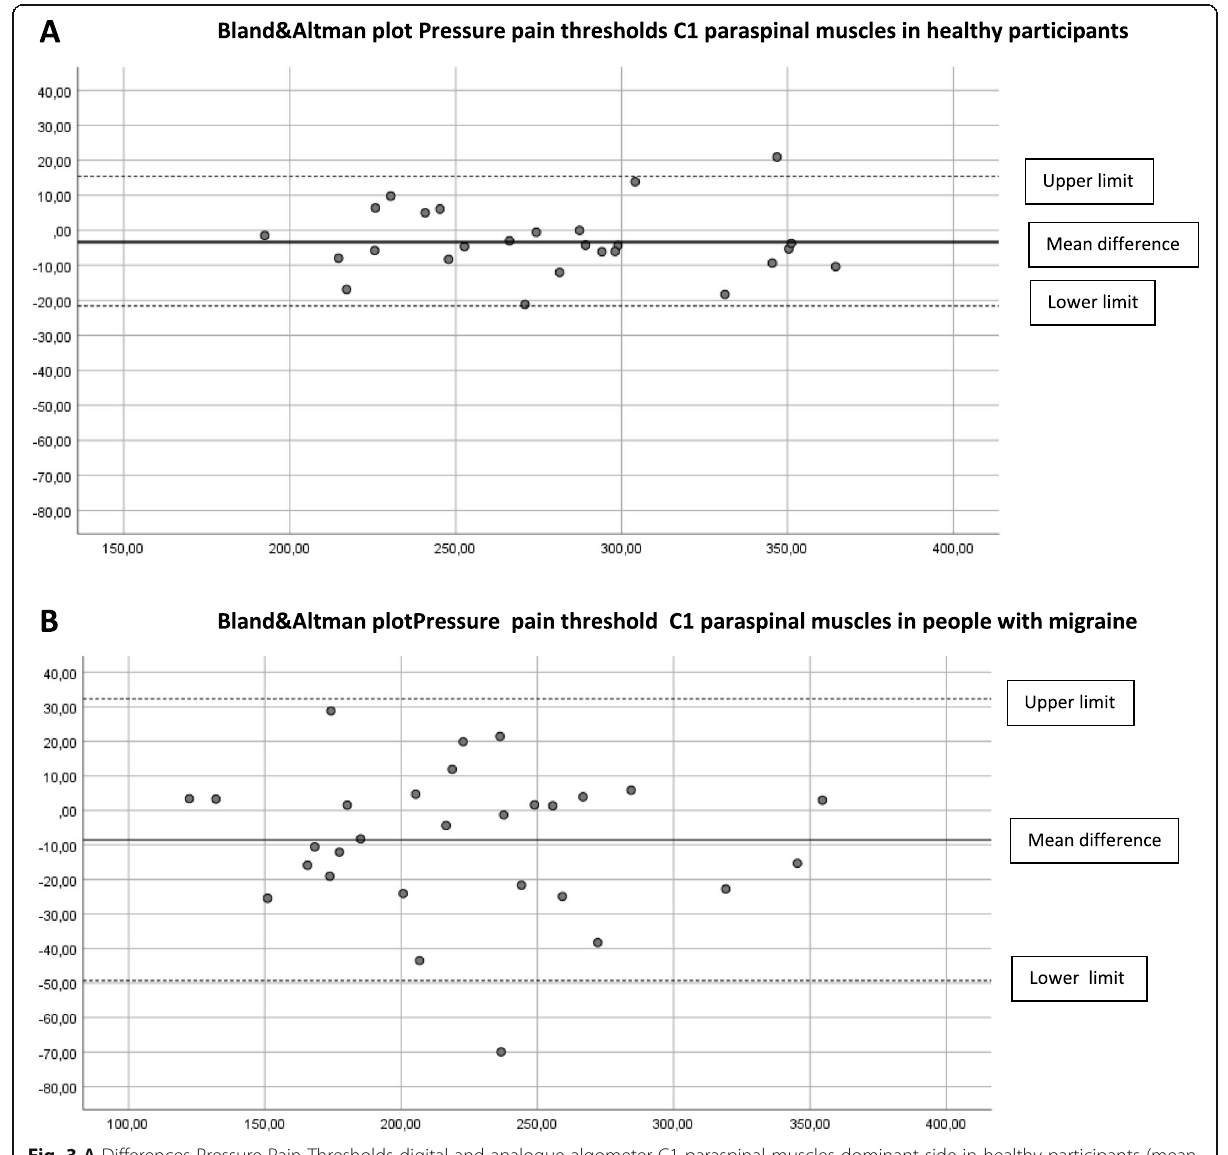
Fig. 3 A Differences Pressure Pain Thresholds digital and analogue algometer C1 paraspinal muscles dominant side in healthy participants (mean difference, upper and lower limit). B Differences Pressure Pain Thresholds digital and analogue algometer C1 paraspinal muscles dominant side in people with migraine (mean difference, upper and lower